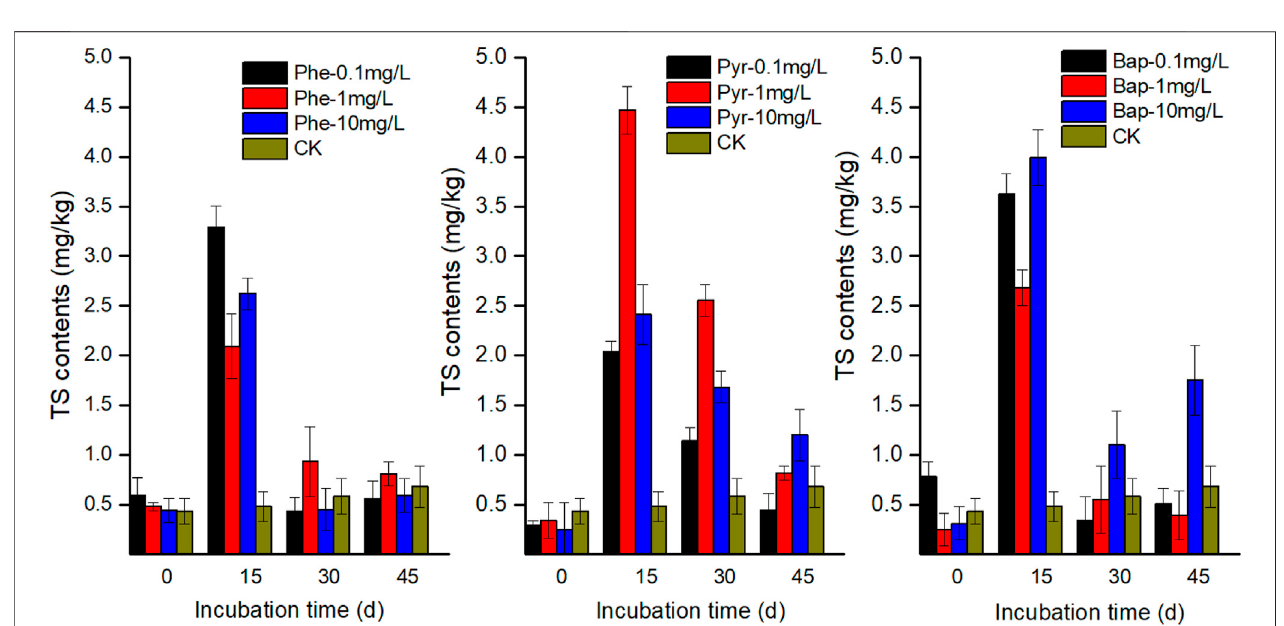
FIGURE 2 | Effect of PAH stress on the amount of total soluble sugar (TS) excreted by B. gymnorrhiza .